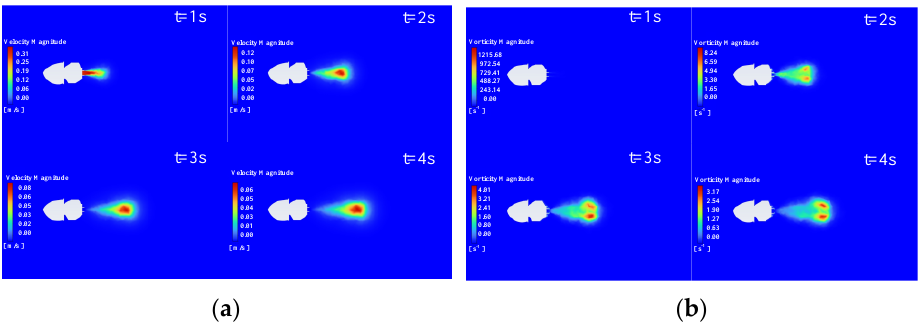
Figure 11. Flow field variation during jetting of the bionic jellyfish robot with 20 mm diameter nozzle ( a ) velocity nephograms at different moments; ( b ) vorticity maps at different moments.